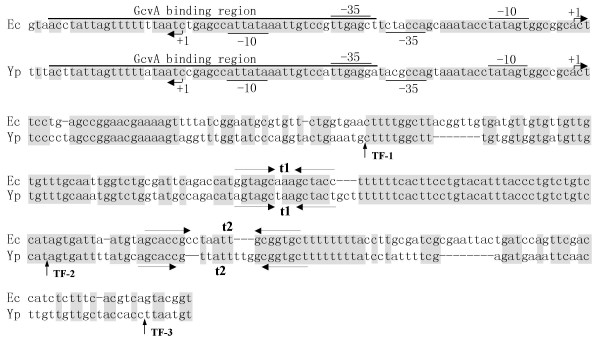
Comparison of the E. coli and Y. pestis gcvA/gcvB control regions and gcvB genes. Ec, E. coli; Yp, Y. pestis. Bases that are identical are boxed in gray. The E. coli promoter -10 and -35 sequences are underlined for gcvA [29] and overlined for gcvB [11]. Arrows indicate transcription start sites and directions of transcription of gcvA and gcvB. The GcvA binding region is indicated above the sequence [30]. The deduced Y. pestis -10 and -35 promoter sequences are underlined for gcvA and overlined for gcvB, and the deduced GcvA binding site is indicated above the sequence. Two Rho-independent transcription terminators for the E. coli and Y. pestis gcvB genes are indicated by inverted arrows. The fusion points for transcriptional fusions gcvB+53::lacZ (TF-1), gcvB+164::lacZ (TF-2) and gcvB+251::lacZ (TF-3) are indicated by vertical arrows.